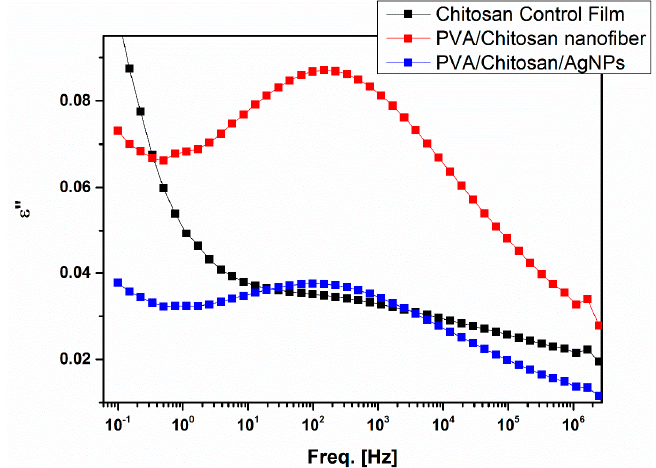
Figure 4. ε ′′ vs. f spectra at − 50 °C for the samples showing Process I.